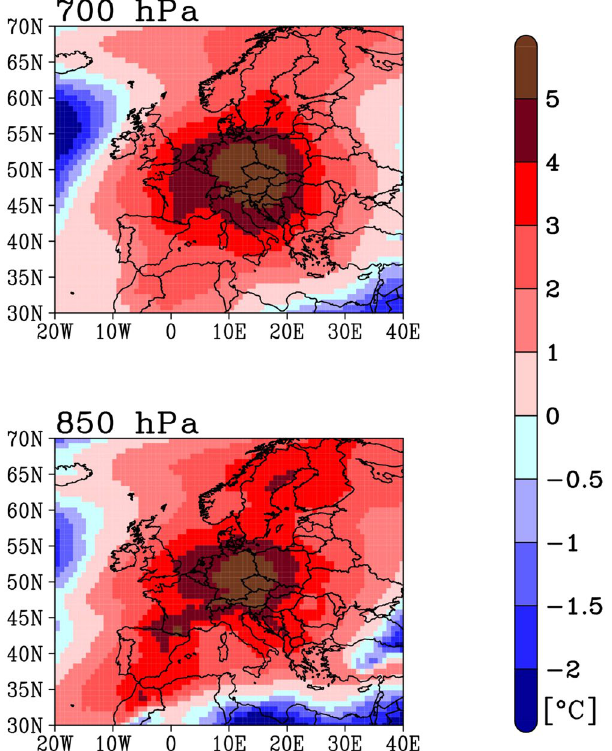
Figure 3. December temperature anomalies at 700 hPa and 850 hPa from the ERA-Interim reanalysis (http:// apps.ecmwf.int/datasets/) for 2015, compared to the reference period 1981–2010. The map was created with the software Grads